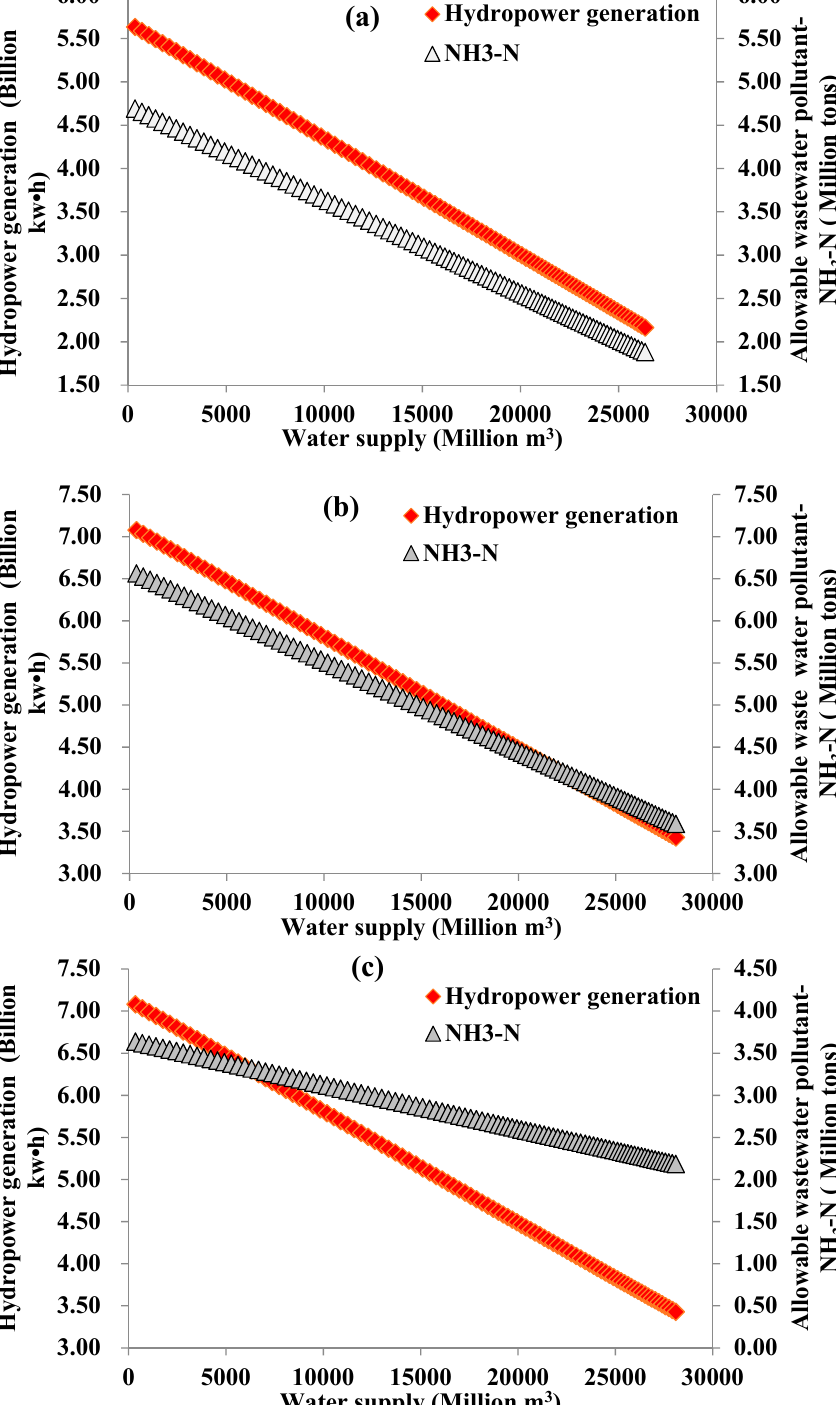
Figure 7. The nexuses of supplied water-allowable wastewater pollutant (NH 3 -N)-hydropower generation: ( a ) p = 99%, C 3 = 1.0 mg / L; ( b ) p = 75%, C 3 = 1.0 mg / L; and ( c ) p = 75%, C 3 = 0.5 mg / L.